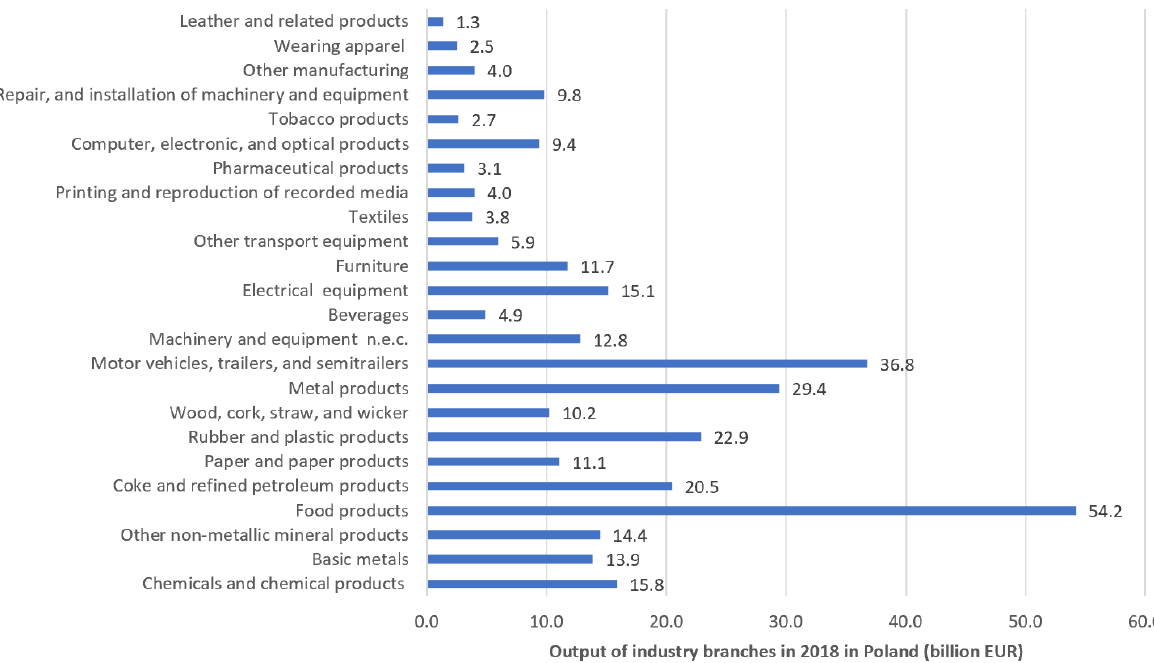
Figure 1. Output of industry branches in 2018 in Poland (billion EUR). Manufacturing overall: 320.1 billion EUR (own study based on Statistics Poland report [38]).